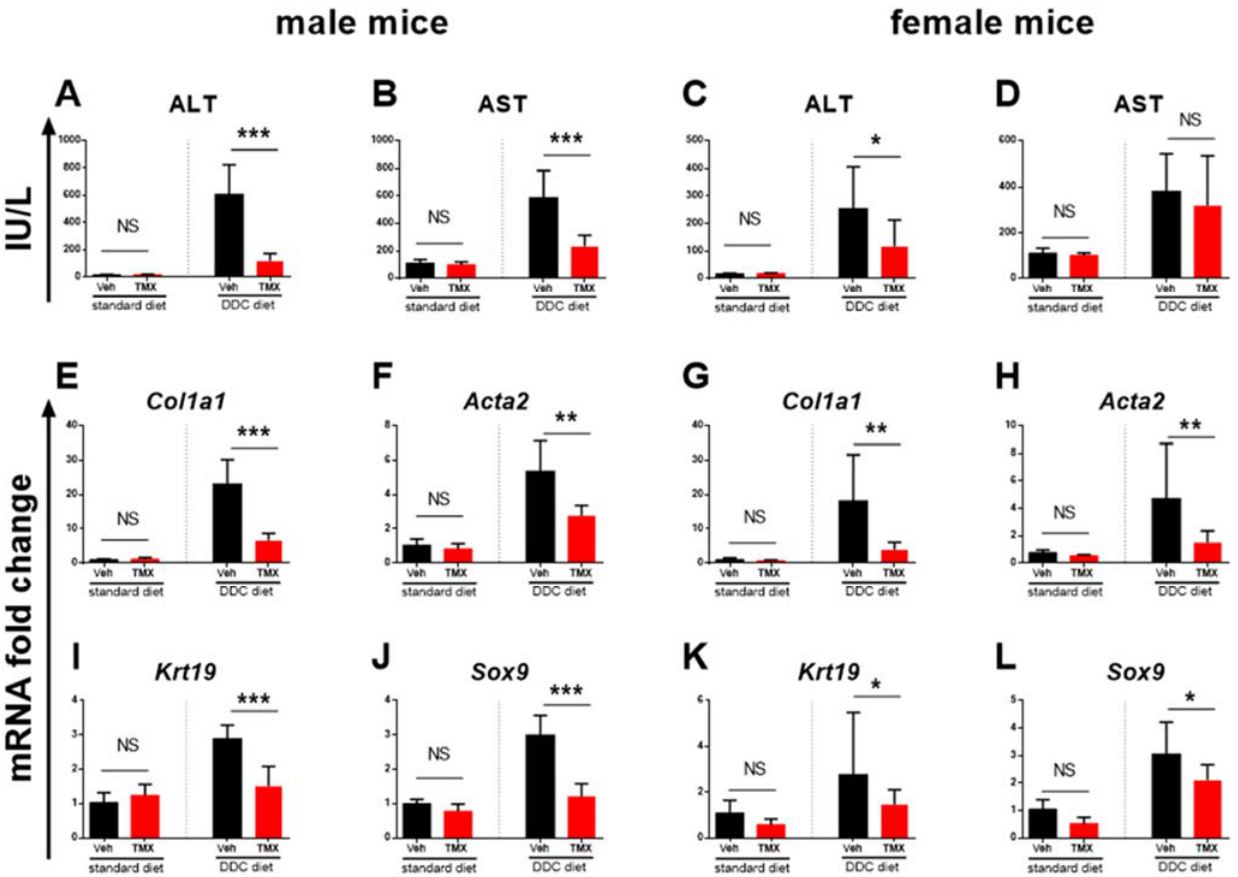
Figure 2. Tamoxifen treatment decreases aminotransferase activity in plasma and expression of genes involved in pathogenesis of biliary fibrosis in liver tissue. Male or female mice were fed standard or DDC ‐ supplemented diet as indicated, and treated with vehicle (black bars) or tamoxifen (red bars). Aminotransferase activity was determined in sera ( A–D ). Gene expression was determined in liver tissue using qPCR ( E–L ). Data represent mean + SD, Student’s t ‐ test was used for comparison between the groups, * p < 0.05, ** p < 0.01, *** p < 0.001, NS—nonsignificant, ALT—alanine ami ‐